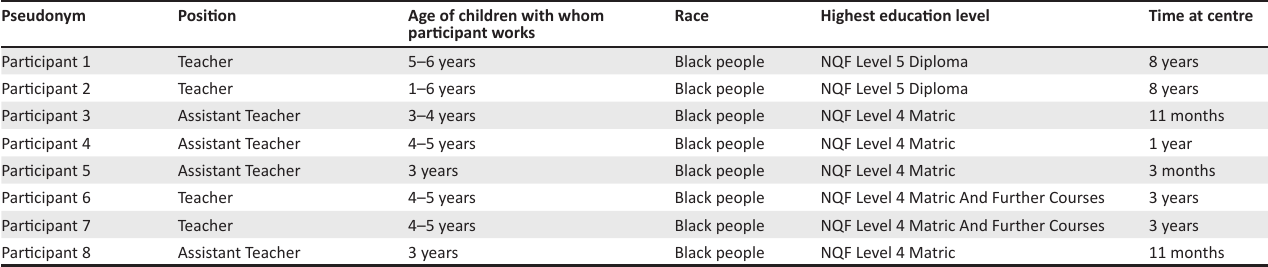
TABLE 1: Participants’